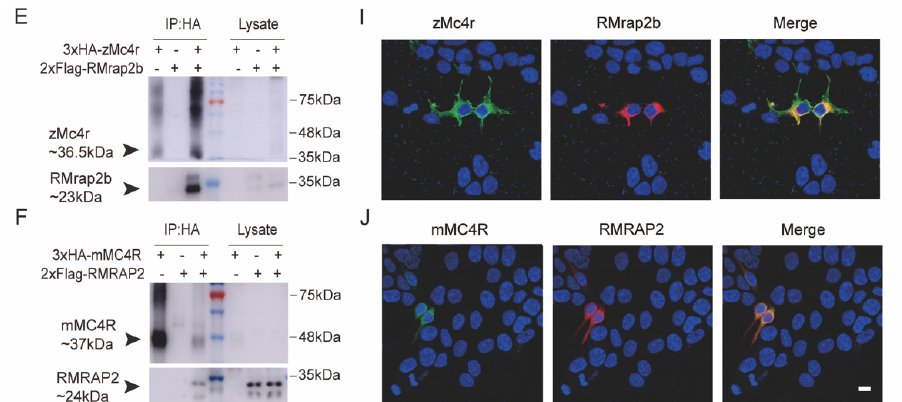
Figure 1. Interaction of RMRAP2 and RMrap2a/b with mMC4R and zMc4r. ( A , B ) Multiple sequence alignment by MUSCLE (3.8) of wild ( A ) and reversed ( B ) zebrafish Mrap2a/b, mouse MRAP2 and human MRAP2. Red frame indicates the transmembrane region. ( C , G ) Negative control. Mouse RAMP3 did not interact with MC4R. ( D – F ) Interactions of MRAP2 with MC4R proteins. Coimmunoprecipitation of 3xHA ‐ Mc4r with 2xFlag ‐ RMrap2a ( D ) or 2xFlag ‐ RMrap2b ( E ) or mouse MC4R and RMRAP2 ( F ) in HEK293T cells. MC4R was detected with mouse anti ‐ HA antibody; MRAP2 was detected with mouse anti ‐ Flag antibody. IP: protein samples with anti ‐ HA immunoprecipitation. Lysate: relevant protein samples to the samples in the IP group but without any immunoprecipitation. ( G – J ) Corresponding immunofluorescence of co-localization of protein complexes on the cell surface. Green indicates zMc4r or mMC4R, and red indicates RMRAP2s. Scale bar = 10 µ m. mMC4R: